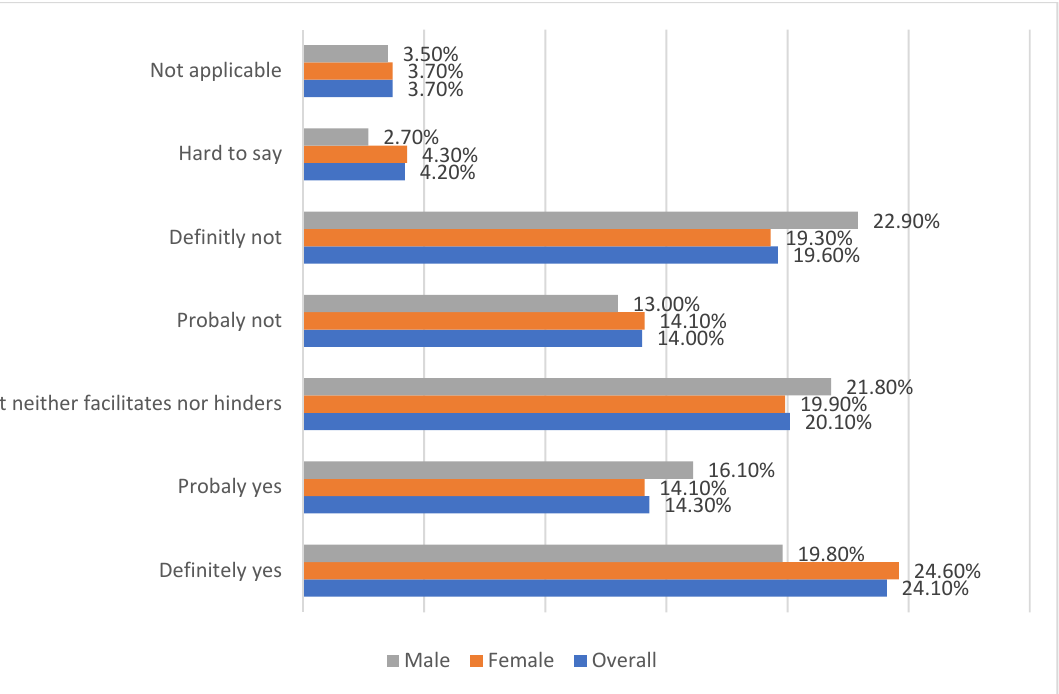
Figure 2. Assessment of the operation of educational and upbringing institutions from the point of view of caring for children (gender) (n = 7800). Source: Authors’ calculations. Note: Pearson’s chi square test for “Sex” resulted in 18,960; df 6.